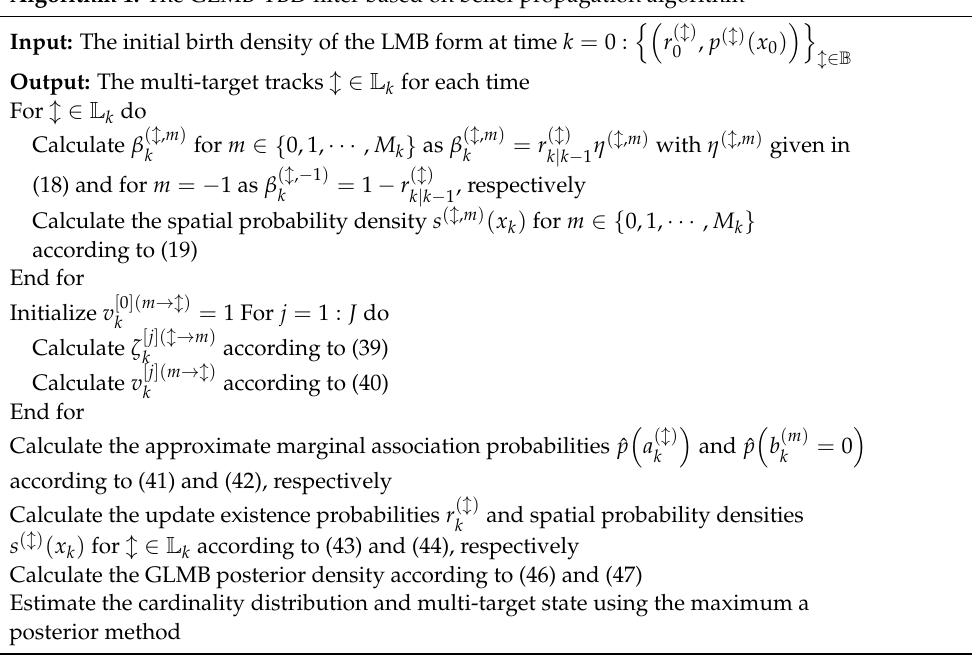
Algorithm 1: The GLMB-TBD filter based on belief propagation algorithm